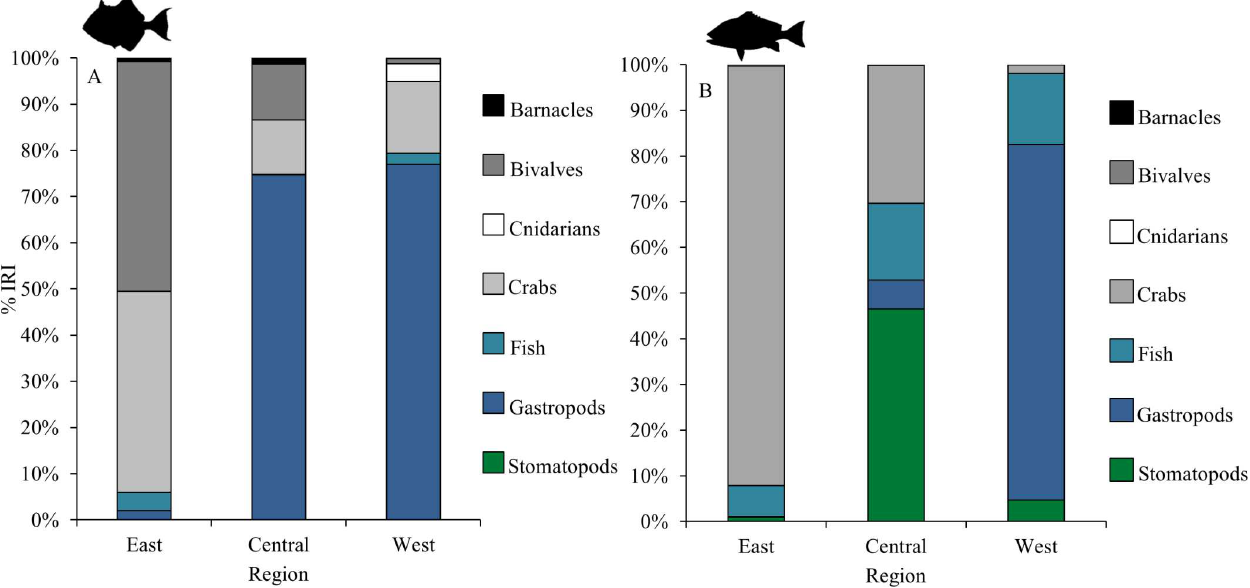
Fig 3. Percent index of relative importance (%IRI) for gray triggerfish and red snapper by region. Prey groups shown are those accounting for more than 1% of the total percent weight (%W) for (A) gray triggerfish in the east (n = 31), central (n = 32), and west regions (n = 26), and for (B) red snapper in the east (n = 178), central (n = 55), and west (n = 26)